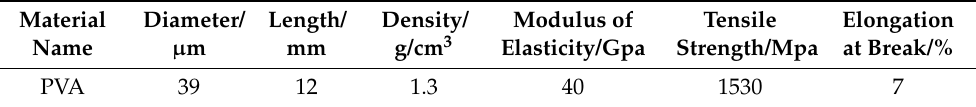
Table 3. Performance index of PVA fiber